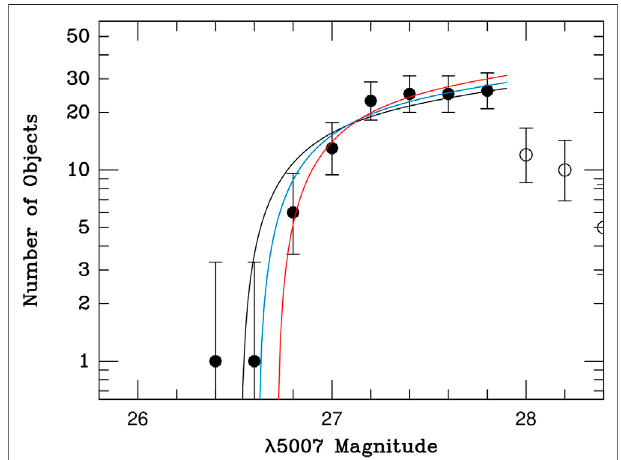
FIGURE 8 | The observed PNLF of the Fornax Cluster lenticular galaxy NGC1380 as measured by Roth et al. (2021). The open circles show measurements fainter than the 90% completeness limit. The black curve shows the best- fi t of Eq. 3 to the data, while the blue curve displays the best fi t if the brightest PNe is arbitrarily excluded from the analysis. The red curve represents the best fi t when the possibility of PN superpositions is included in the analysis. The offsets between the curves illustrate how a fi t using Eq. 3 can introduce a systematic error into PNLF distances, even when obvious overluminous objects are removed from the